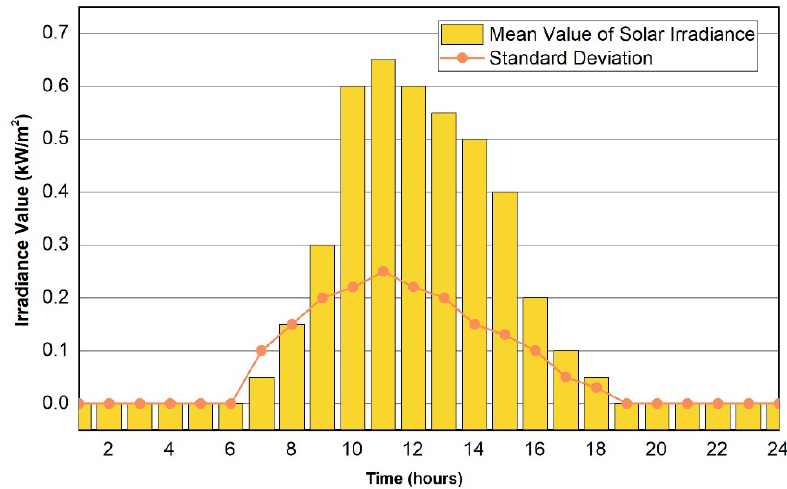
Figure 2. Mean and standard deviation curves.